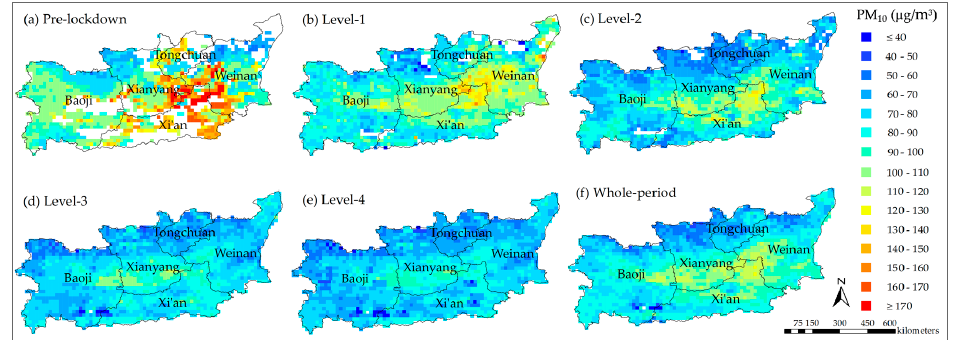
Figure 10. Maps showing the spatial distributions of the PM 10 concentrations in the Guanzhong Basin as predicted by the GTWR model, averaged for each stage before and after the COVID-19 outbreak: Pre- lockdown stage ( a ), Level-1 stage ( b ), Level-2 stage ( c ), Level-3 stage ( d ), Level-4 stage ( e ) and over the whole study period ( f ) from 1 January to 24 June in 2020.